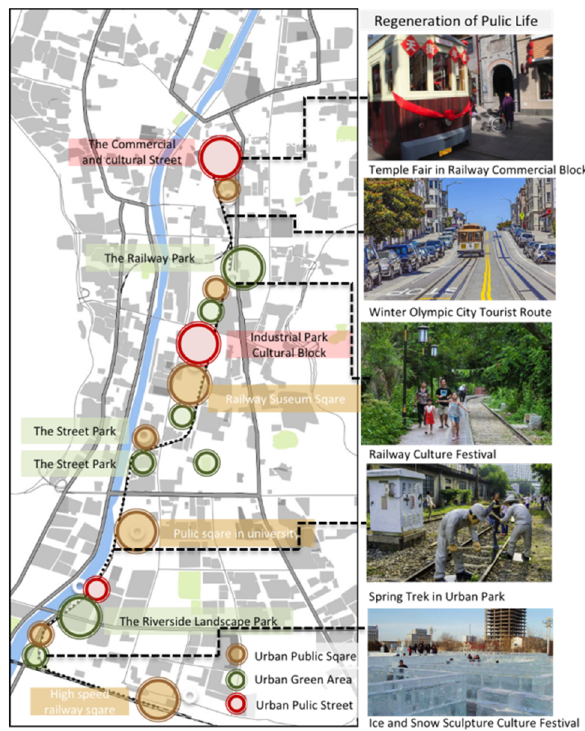
Fig. 9 The regeneration of public space and public life. Source : Drawn by the